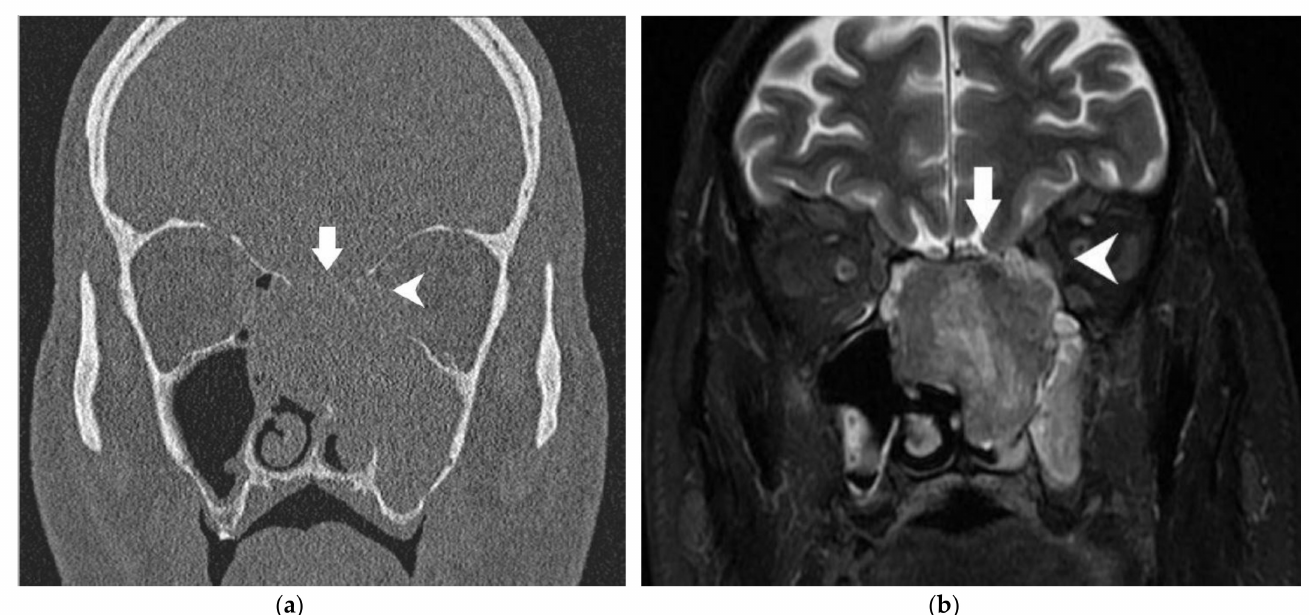
Figure 2. Sixty-three-year-old male subject with left ethmoido-maxillary non-intestinal-type adenocarcinoma. ( a ) Coronal CT scanner: major erosion of cribriform plate (white arrow) and lamina papyracea (white arrowhead). ( b ) Coronal MRI (T2 acquisition with fat saturation): white arrow: minor modification of bony skull base; white arrowhead: major modification of lamina papyracea, regular deformation of orbital content, invasion of the fat between tumor and oculomotor muscle. In the radiological conclusion, the bony skull base, dura, cerebral parenchyma, orbital bony walls and orbital content were all considered